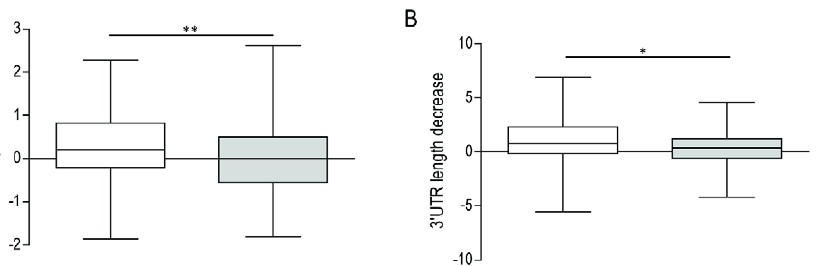
Figure 7. TPGs with type 2 domains (not known to be involved in DNA-binding, protein-interaction, kinase or histone modification) play a role in boosting transcription and mRNA stability of fusion gene. Comparison of TPGs with type 1 domains (grey boxes) and type 2 domains (white boxes). A: Transcription increase afforded by 5 9 TPGs, calculated as ((Pol2 occupancy of 5 9 TPG promoter) 2 (Pol2 occupancy of 3 9 TPG promoter)). B: Decrease of 3 9 -UTR length afforded by 3 9 TPGs, calculated as log2((3 9 -UTR length of 5 9 TPG)/(3 9 -UTR length of 3 9 TPG)). *, **: P , 0.05, 0.01; two-tailed T-test.